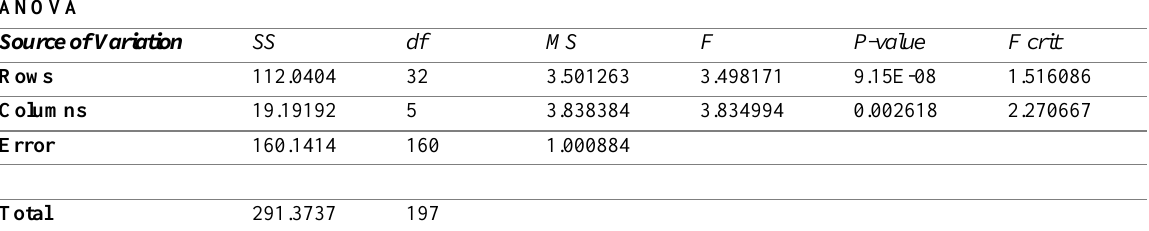
Table 6: Views of Computational thinking